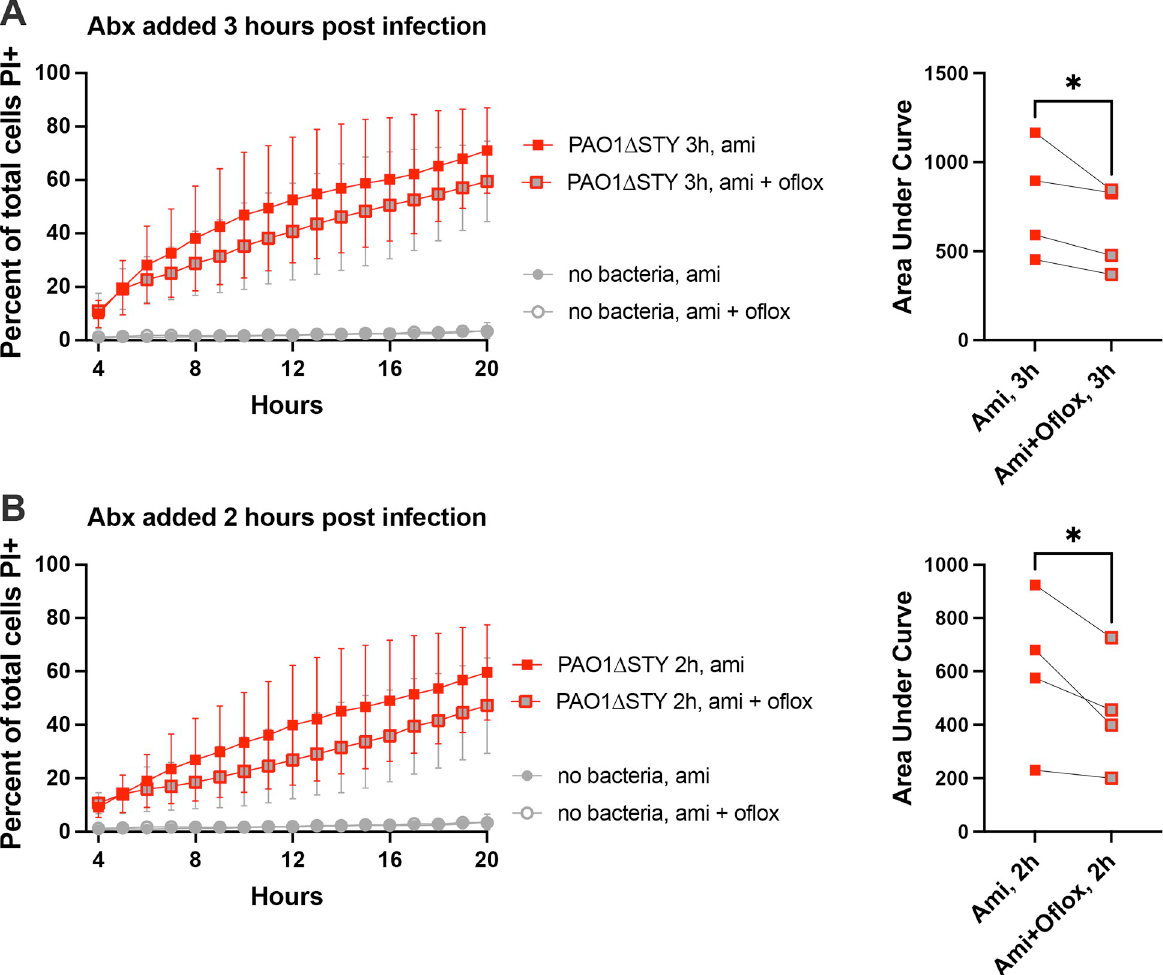
Fig 10. Ofloxacin treatment reduces host cell death after bacterial invasion. Corneal epithelial cells were infected with PAO1 Δ exoSTY for ( A ) 3 h or ( B ) 2 h, and either 200 μ g/mL amikacin alone, or 200 μ g/mL amikacin combined with 25 μ g/mL ofloxacin, added to eliminate extracellular bacteria only, or both extracellular and intracellular bacteria, respectively. Cell death was tracked using Hoechst and propidium iodide staining in time-lapse images from 4–20 h post-infection and plotted as a percentage. The addition of ofloxacin to kill intracellular bacteria reduced overall cell death. Four replicates are shown for each condition with area under the curve plotted for each replicate to demonstrate a consistent reduction in cell death with ofloxacin treatment. � P < 0.05 (paired Student’s